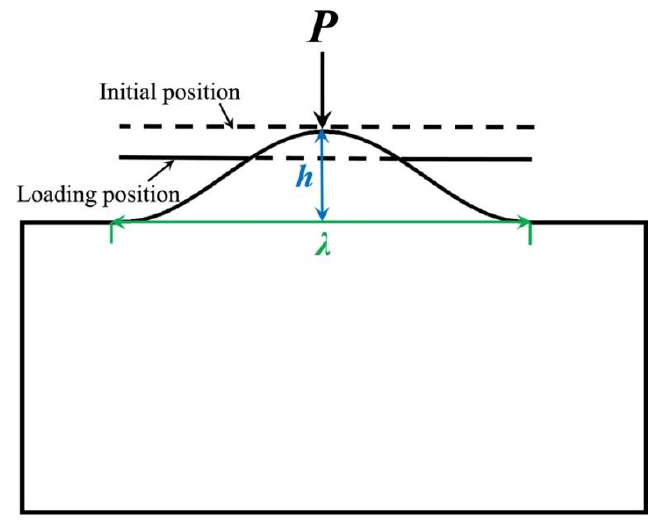
Figure 5. Schematic of a sinusoidal asperity loaded with a rigid flat surface.